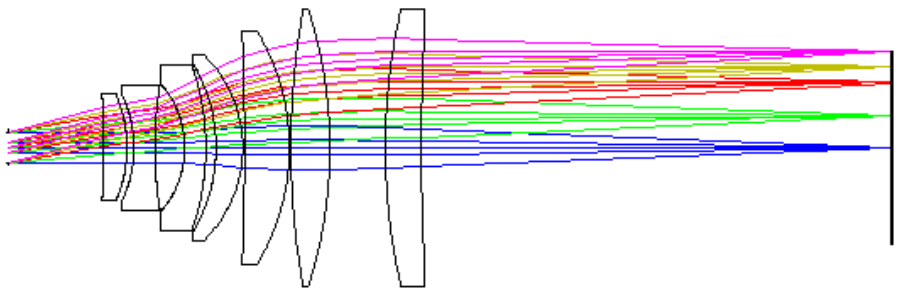
Figure 5. The structure diagram of an f-theta lens designed by ZEMAX, 0° in blue, 5° in green, 10° in red, 12.5° in yellow, 15° in pink.